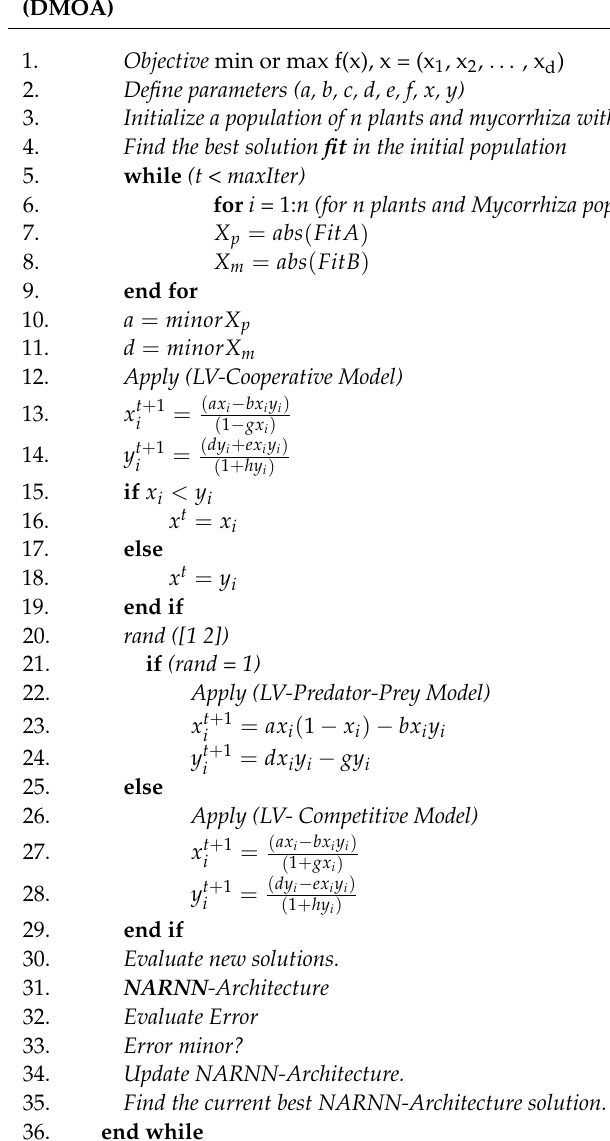
Algorithm 1 DMOA-NARNN Pseudocode. Discrete Mycorrhiza Optimization